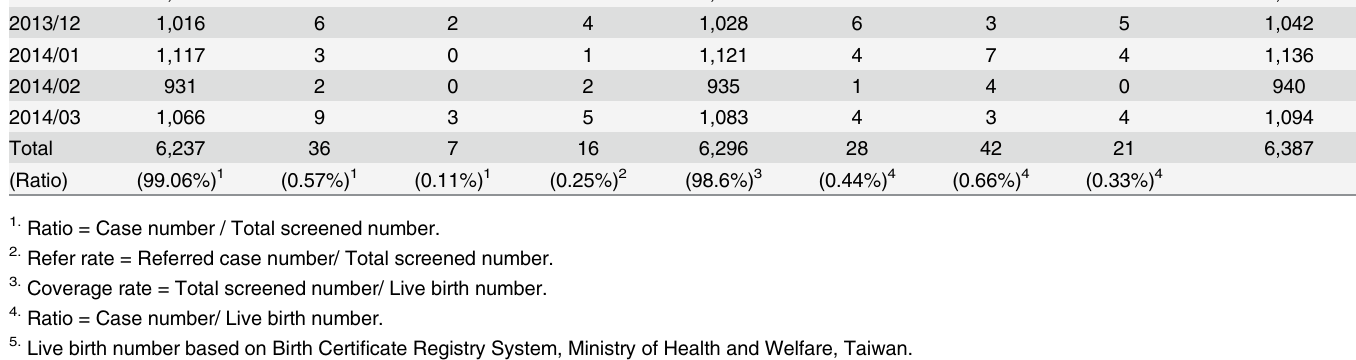
1. Ratio = Case number / Total screened number. 2.